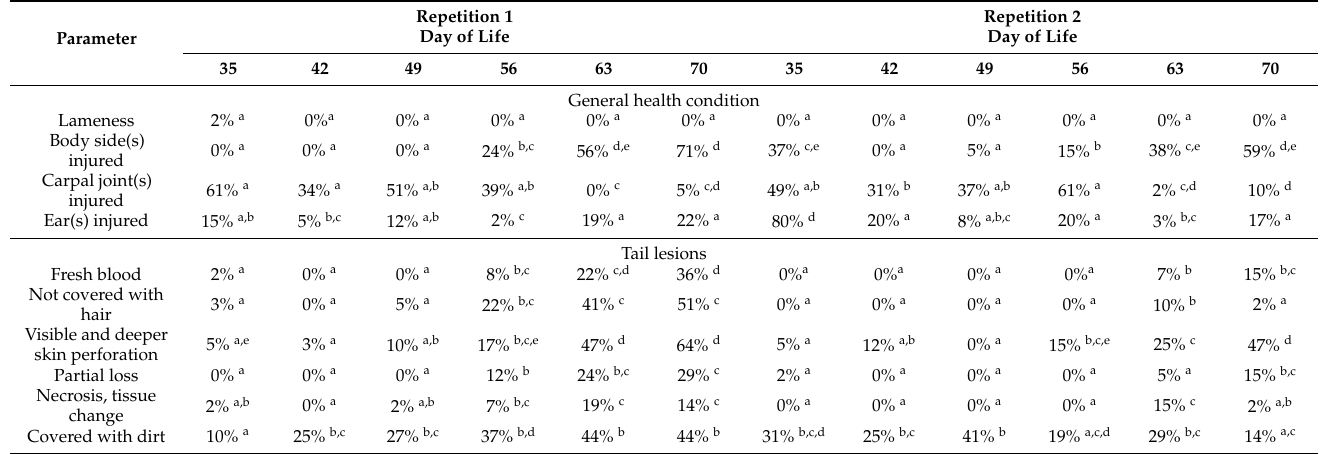
Table 5. Scored parameters with proportion (%) of pigs for each score.